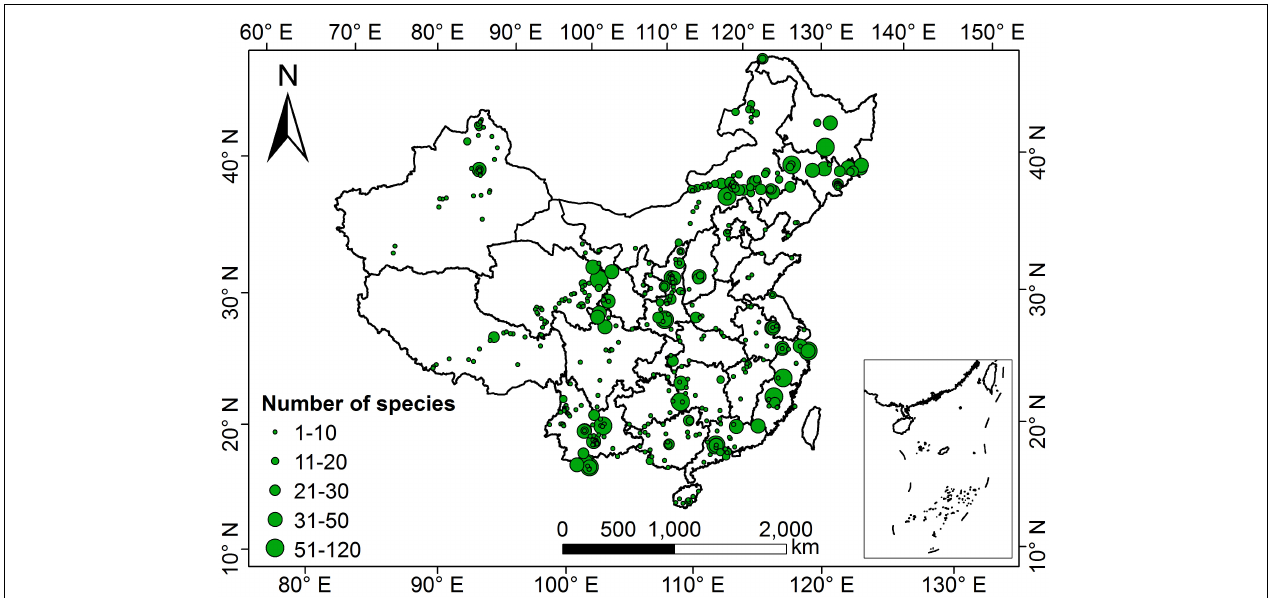
FIGURE 1 | Geographical distribution of sampling sites in China. The size of the green dots on the map indicates the relative number of species measurements.